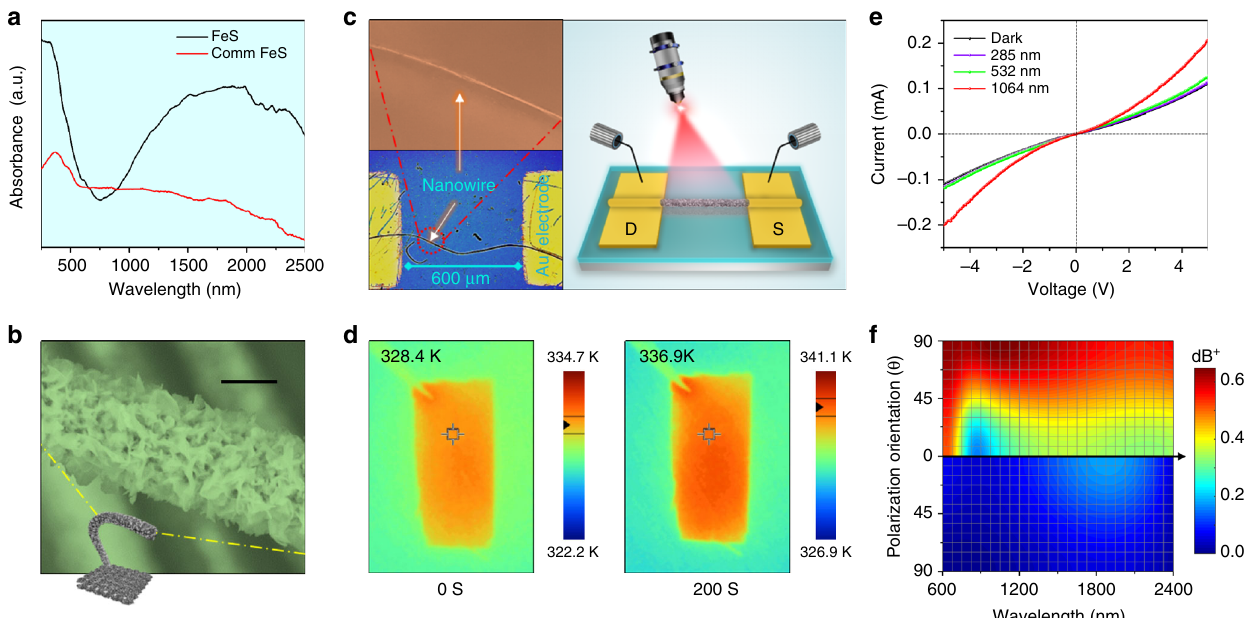
Fig. 3 Physical mechanism of photoinduced phase transition. a Absorption spectra of ultrathin FeS nanosheets and commercial FeS powders. b FE-SEM image of a single carbon fi ber covered by ultrathin FeS nanosheets (scale bar, 5 μ m). c Schematic and optical image of a single photodetector structure. d Infrared imaging pictures of FeS/CFC. e I – V curves of the photodetector without and with light illumination at different wavelengths. f Absorption behavior as a function of polarization orientation and incident light